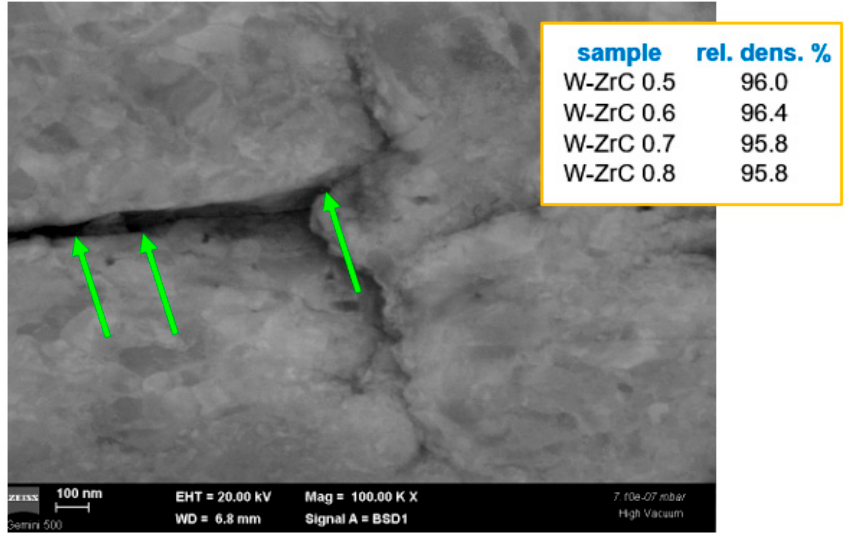
Figure 5. Cross-section SEM image obtained using a backscattered electron detector for W-ZrC materials. The inset summarizes the density values of these materials.